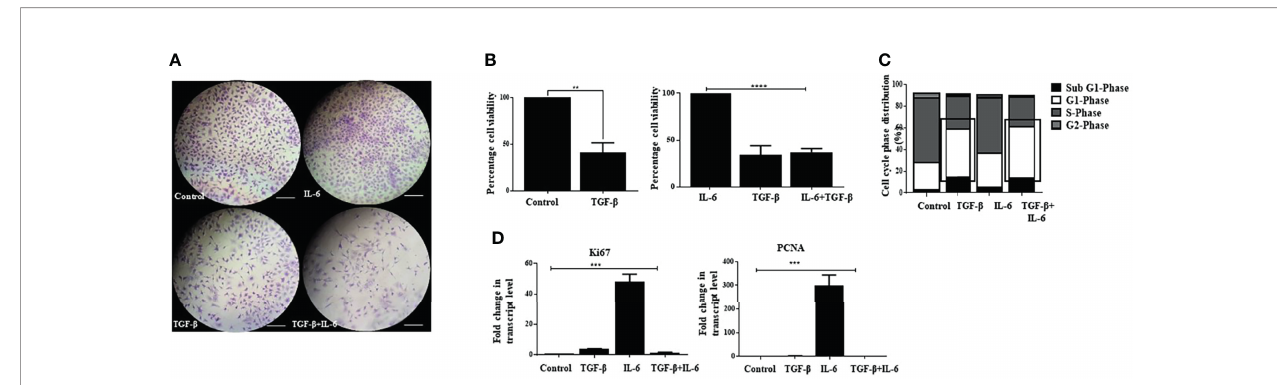
FIGURE 6 | IL-6-induced cellular proliferation is attenuated by TGF- b . (A) Crystal violet staining after exposure to TGF- b or IL-6 or TGF- b plus IL-6 for 72 h compared to untreated control (scale bar: 100 m m). (B) Analysis of cell viability after TGF- b /IL-6 or TGF- b plus IL-6 treatment for 72 h. (C) Analysis of cell cycle stages after treatment with TGF- b /IL-6 or TGF- b plus IL-6 for 72 h. (D) Transcript levels of Ki67 and PCNA after TGF- b /IL-6 or TGF- b plus IL-6 treatment for 72 h. **, *** and **** refers to p value signi fi cance of ≤ 0.01, ≤ 0.001 & ≤ 0.0001